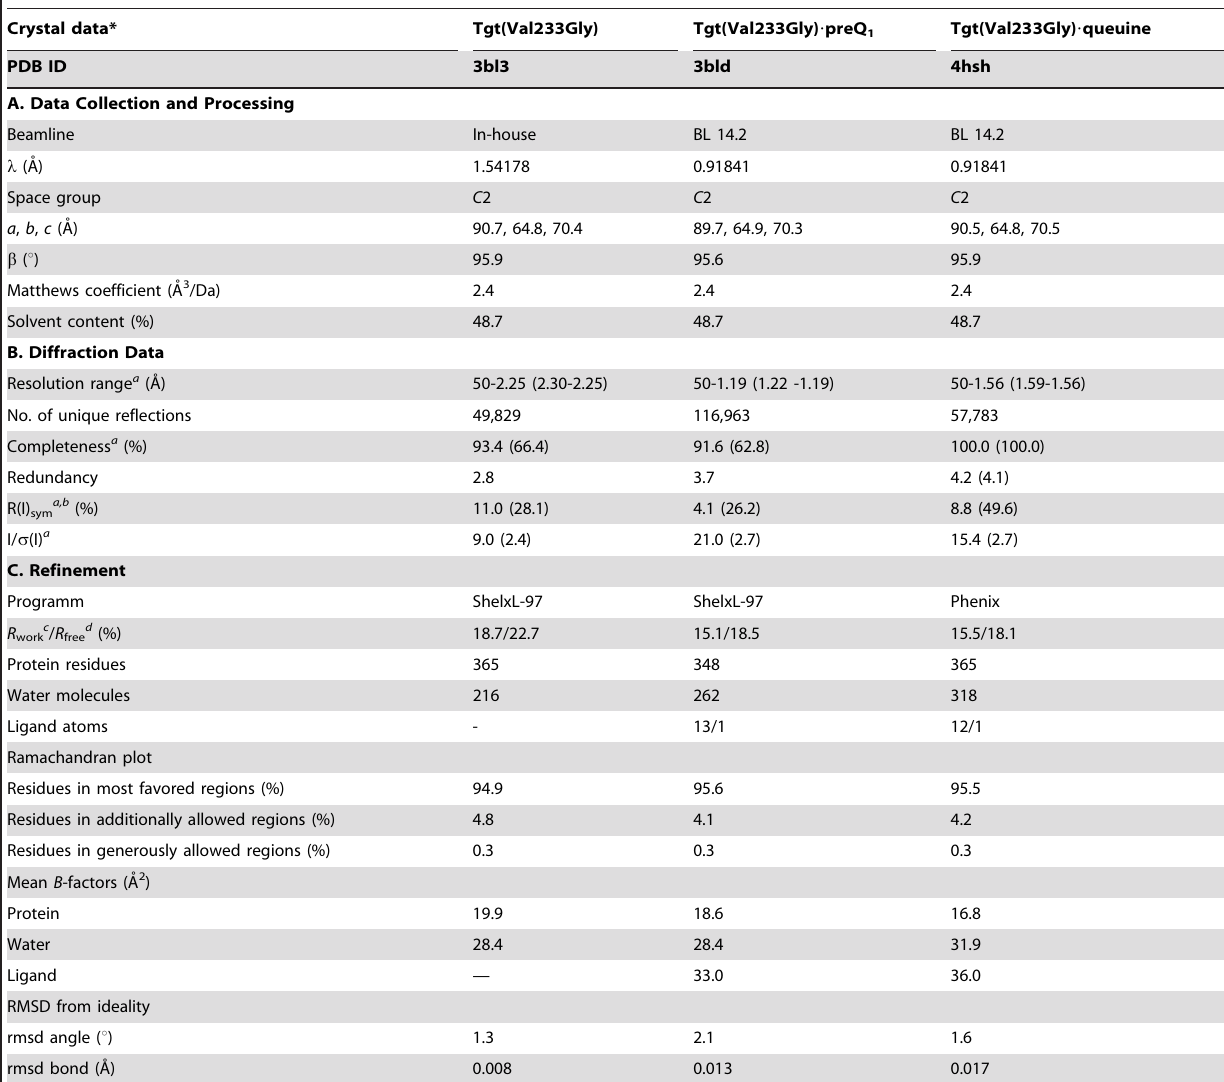
Table 3. Crystallographic data collection and refinement statistics – Tgt(Val233Gly).